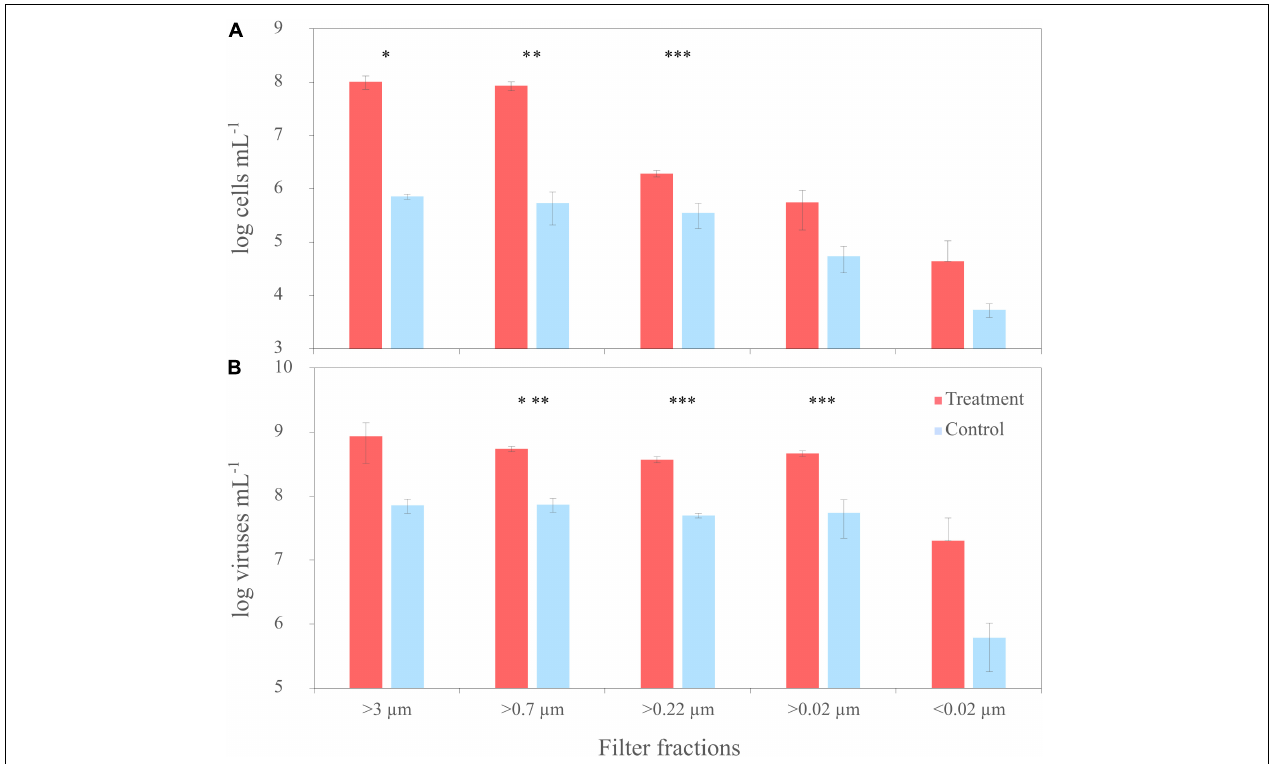
FIGURE 6 | Trends of cell numbers (A) and virus abundances (B) of the sequential filtration of untreated North Sea water (NSW) through filters with various pore sizes (‘untreated’) and NSW spiked with a cell lysate of R. sulfidophilum (‘spiked’). Biological replicates are averaged ( n = 3) and standard deviations indicated by the error bars. Asterisks indicate significant differences between treatments and controls (* p < 0.05, ** p < 0.01, *** p <